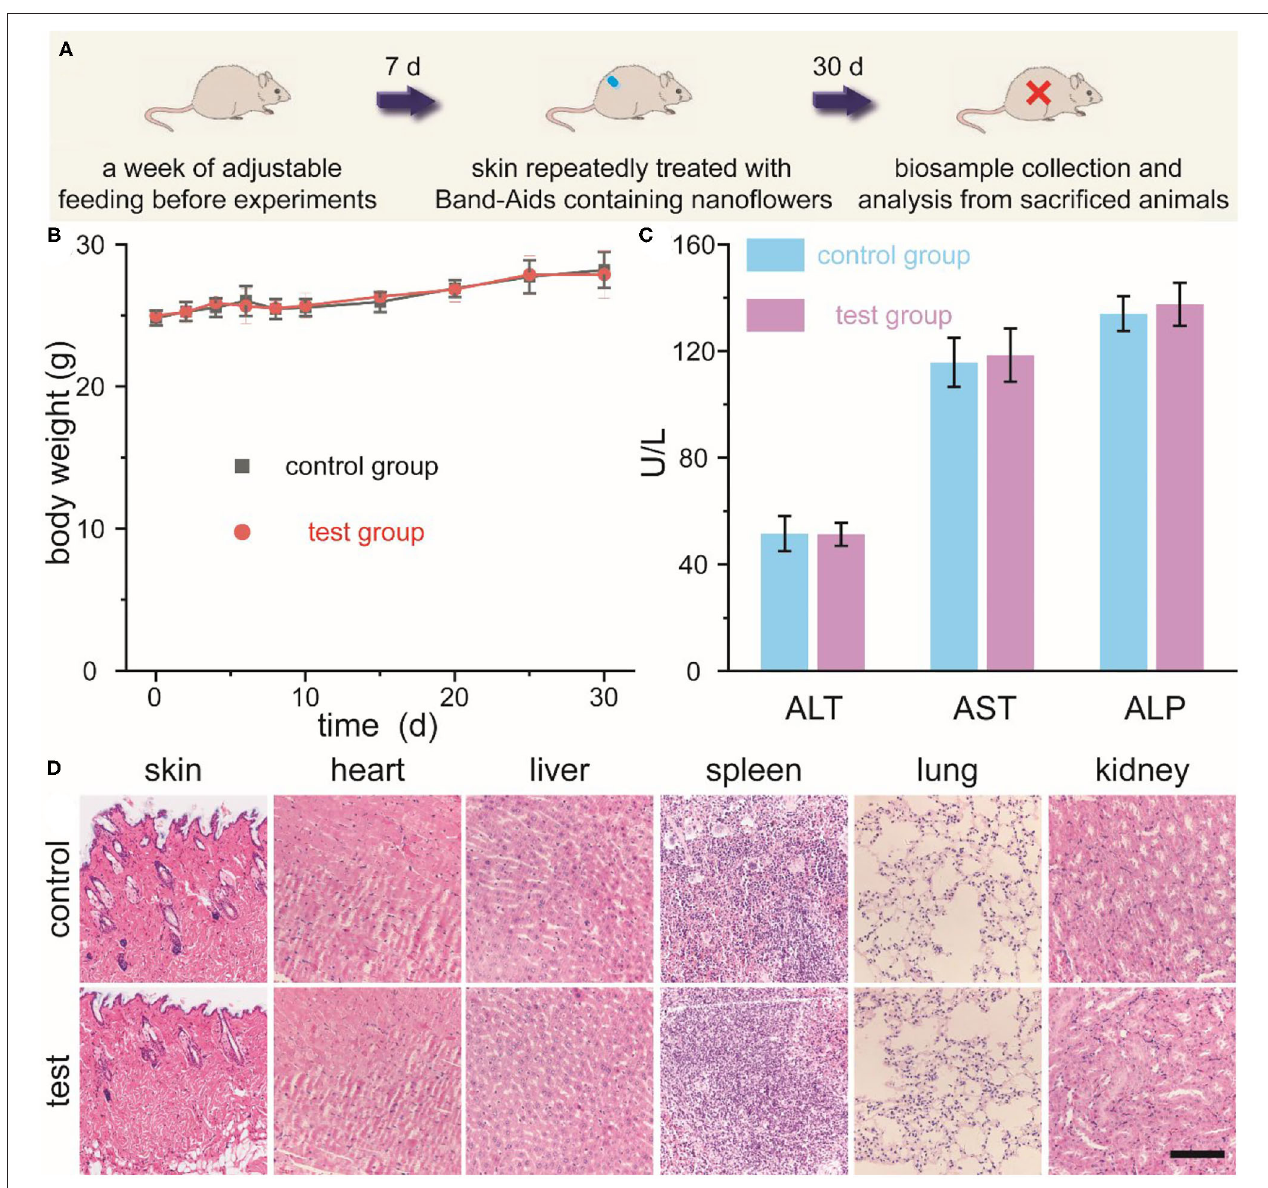
FIGURE 6 | Schematic illustration for the experimental design of skin sensitivity and long-term toxicity investigation of nanoflowers (A) . Changes in body weight (B) , main blood biochemical assay (C) , as well as histological observation (D) of mice repeatedly treated with or without Band-Aids containing nanoflowers. Scale bar was equal to 200 µ